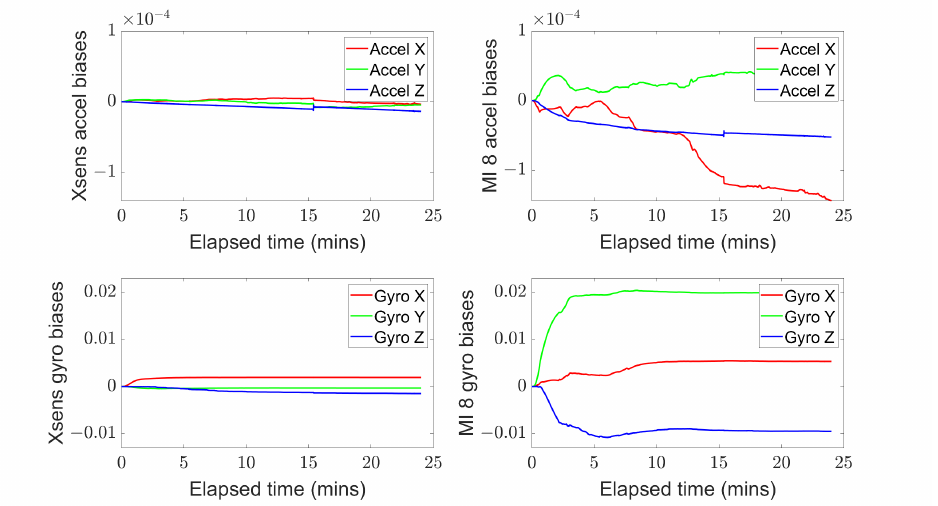
Figure 6. Times series of estimated IMU accelerometer and gyroscope biases with along three